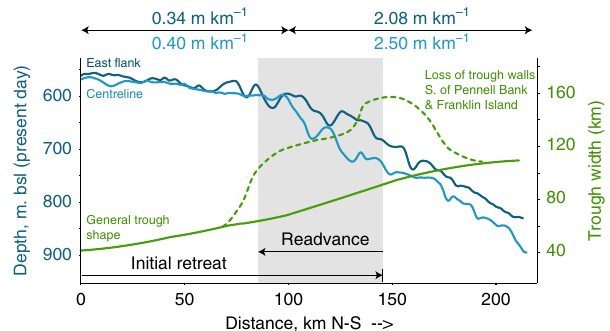
Fig. 6 JOIDES Trough geometry through which grounding line advance occurs. Initial retreat stabilisation and grounding line advance through GZW progradation appears an unlikely explanation, since the retreated stable position would occur where bed slope (in blue) increases and where trough width (in green) widens. An additional dynamic component is therefore required to drive a